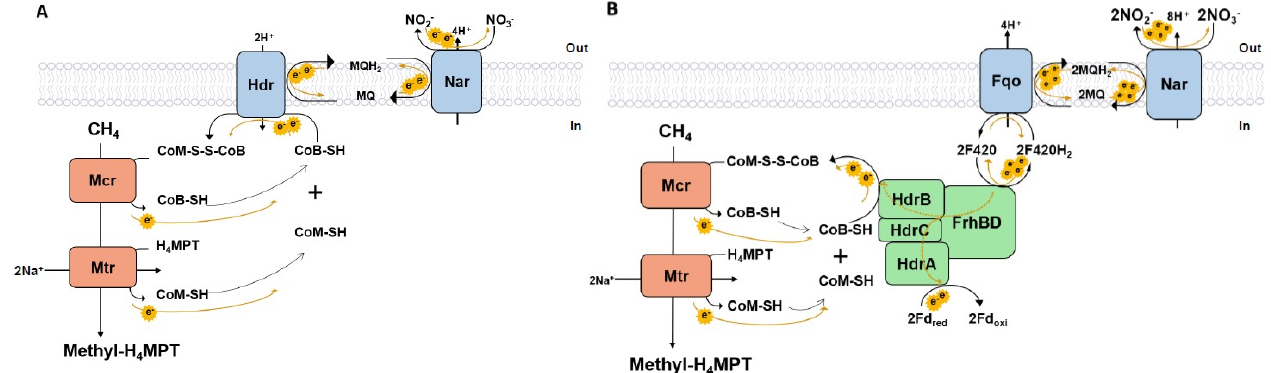
Figure 4. Electron transfer routes related to two heterodisulfide reductase classes. ( A ) Electron tranfer routes centred on membrane − bound heterodisulfide, HdrDE. ( B ) Electron transfer routes centred on in-cytoplasmic heterodisulfide, HdrABC. The yellow arrows represent the electron movements, and the dashed arrows correspond to the hypothetical electron − confurcating mode.